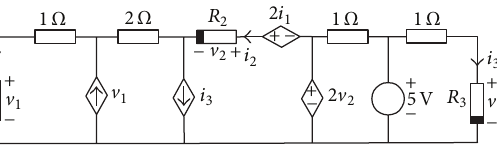
Figure 6: Three nonlinear resistor circuits.